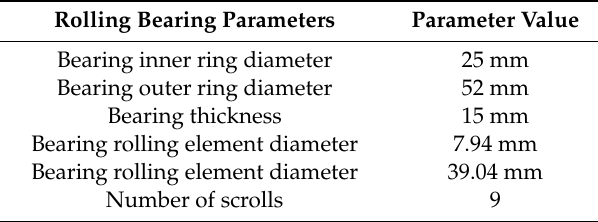
Table 2. Dimension parameters table of the rolling bearing.